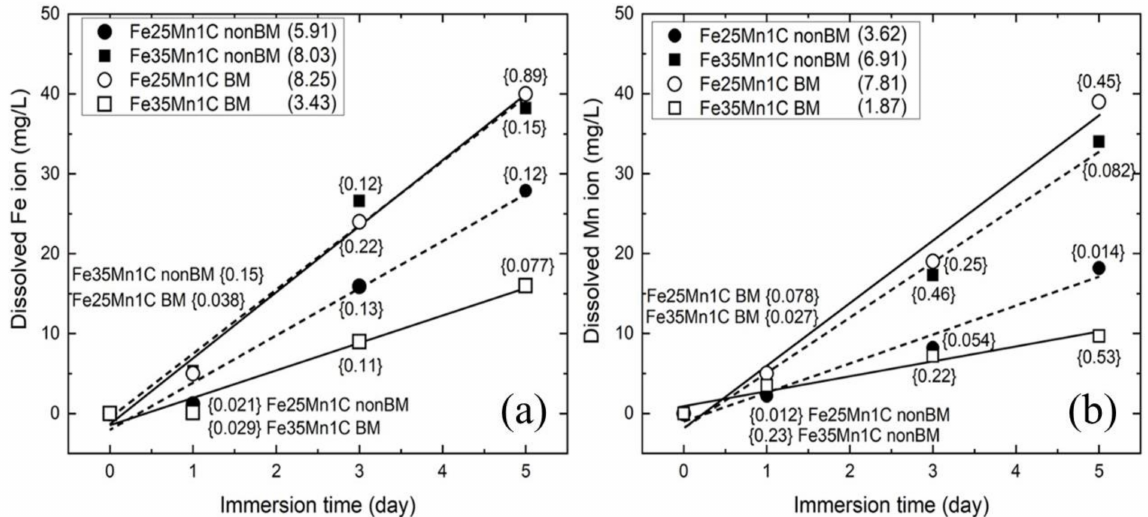
Figure 7. The concentration of released Fe ion ( a ) and Mn ion ( b ) upon immersion in the Ringer’s lactate solution. Numbers in the legend indicate a rate of ion release in the unit of mg/L/day. The numbers in curly brackets show the standard deviation of the released ion